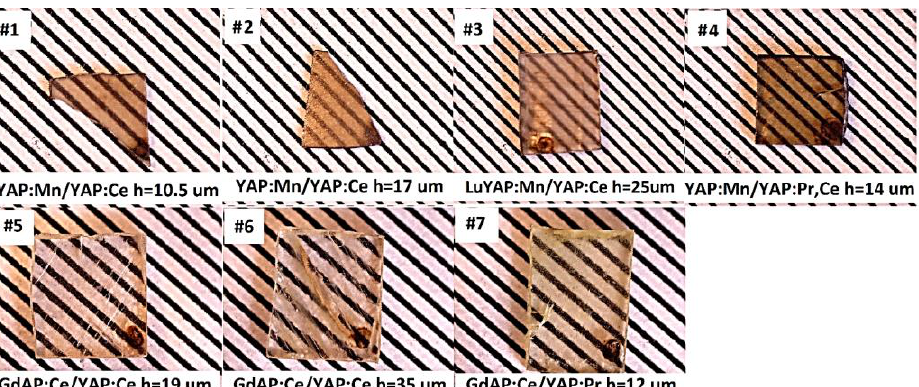
Figure 2. Photos of YAP:Mn SCF/YAP:Ce SC, LuYAP:Mn SCF/YAP:Ce SC, YAP:Mn SCF/ YAP:Pr SC (on the top) and GdAP:Ce SCF/YAP:Ce SC, GdAP:Ce SCF/YAP:Pr SC (on the bottom) composite TL detector. Table 1. Conditions of the LPE growth of GdAP:Ce SCF/YAP:Ce (Pr) SC and YAP:Mn and